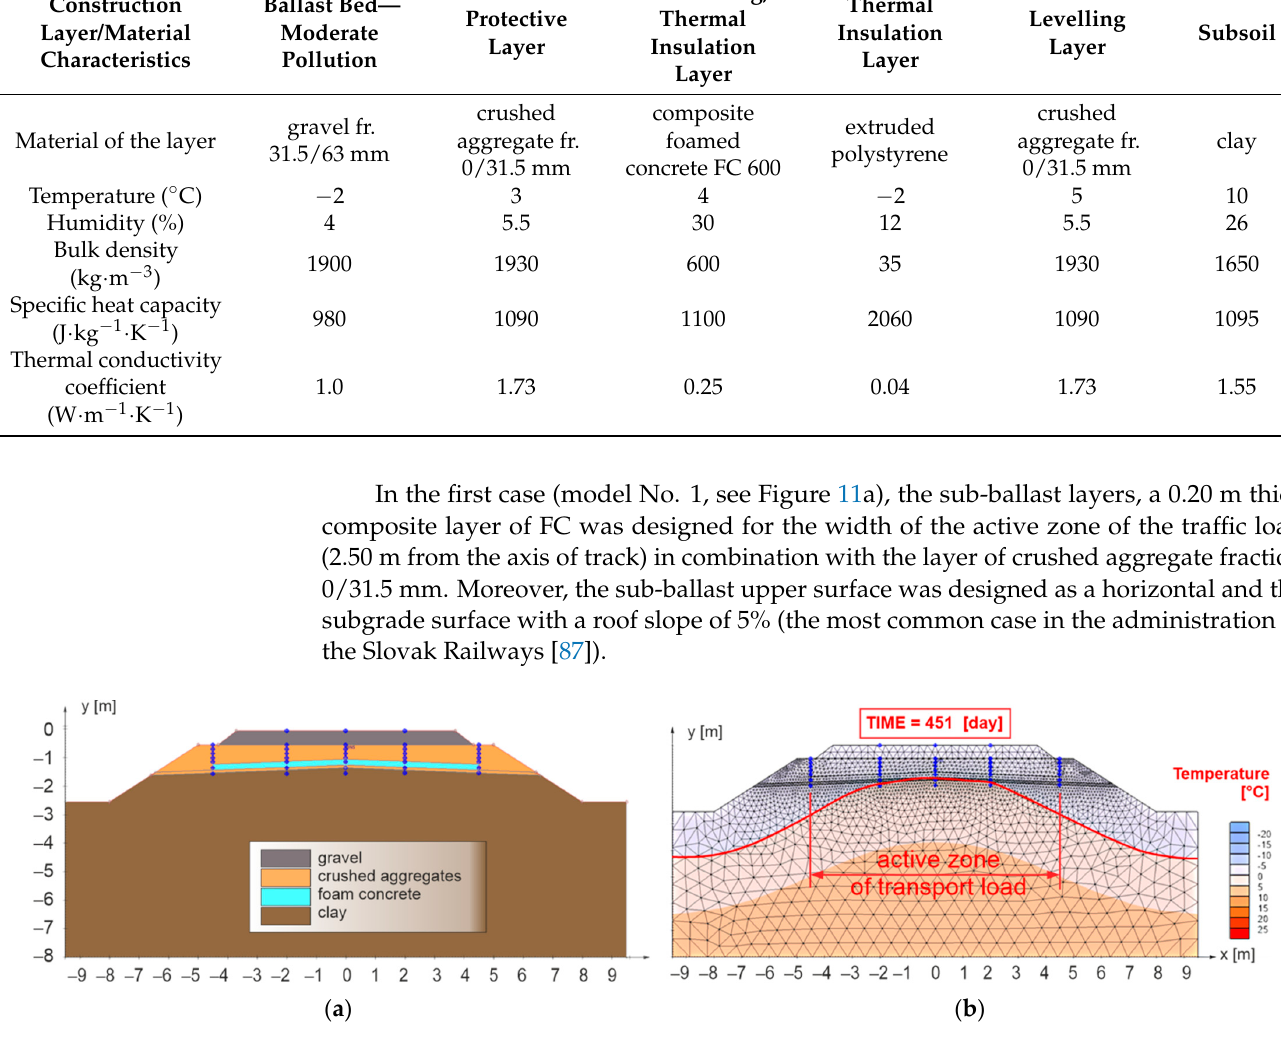
Table 6. Input parameters of numerical modelling—material characteristics.